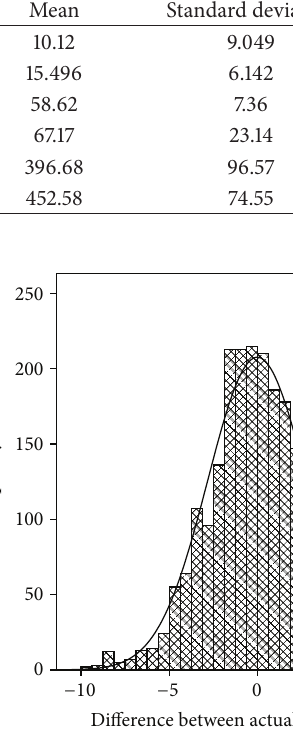
Figure 3: Distribution of the difference between actual temperature values and predicted temperature values obtained from multivariate regression